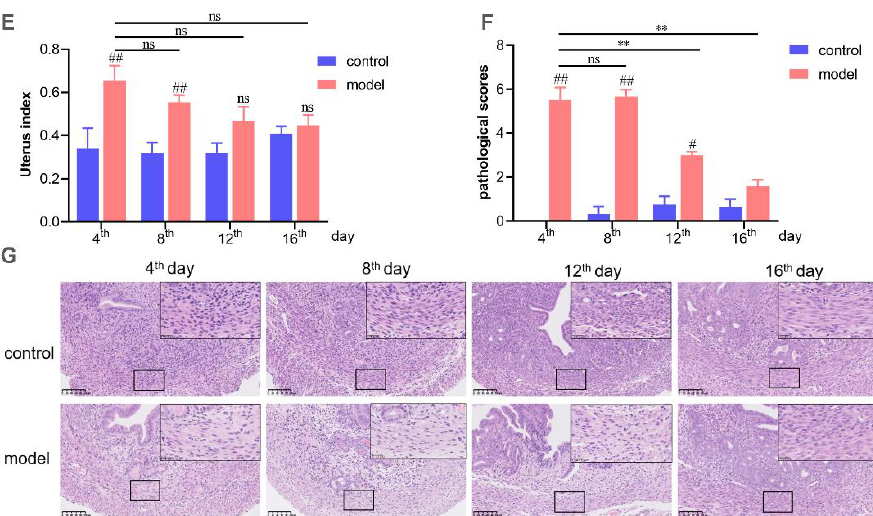
Figure 1. The regular detection indexes relative to the PD mice model. ( A ) Photomicrographs of vaginal smear from mice at proestrus ( a ), estrus ( b ), metestrus ( c ), and diestrus ( d ). ( B ) The percentage of each estrous stage from model group on 4th, 8th, 12th, and 16th days. ( C ) Body weight changes of the mice. ( D ) Oxytocin-induced writhing response score during the experiment. ( E ) Uterus index of control group and model group on 4th, 8th, 12th, and 16th days. ( F ) Pathological scores of uterus H&E staining. ( G ) Example pathological section of the uterus with H&E staining (20×). # Model group compared with corresponding control group. # p < 0.05; ## p < 0.01. * p < 0.05; ** p < 0.01. ns, no significance. (n = 6 per group). The statistical values are presented in Table S1.